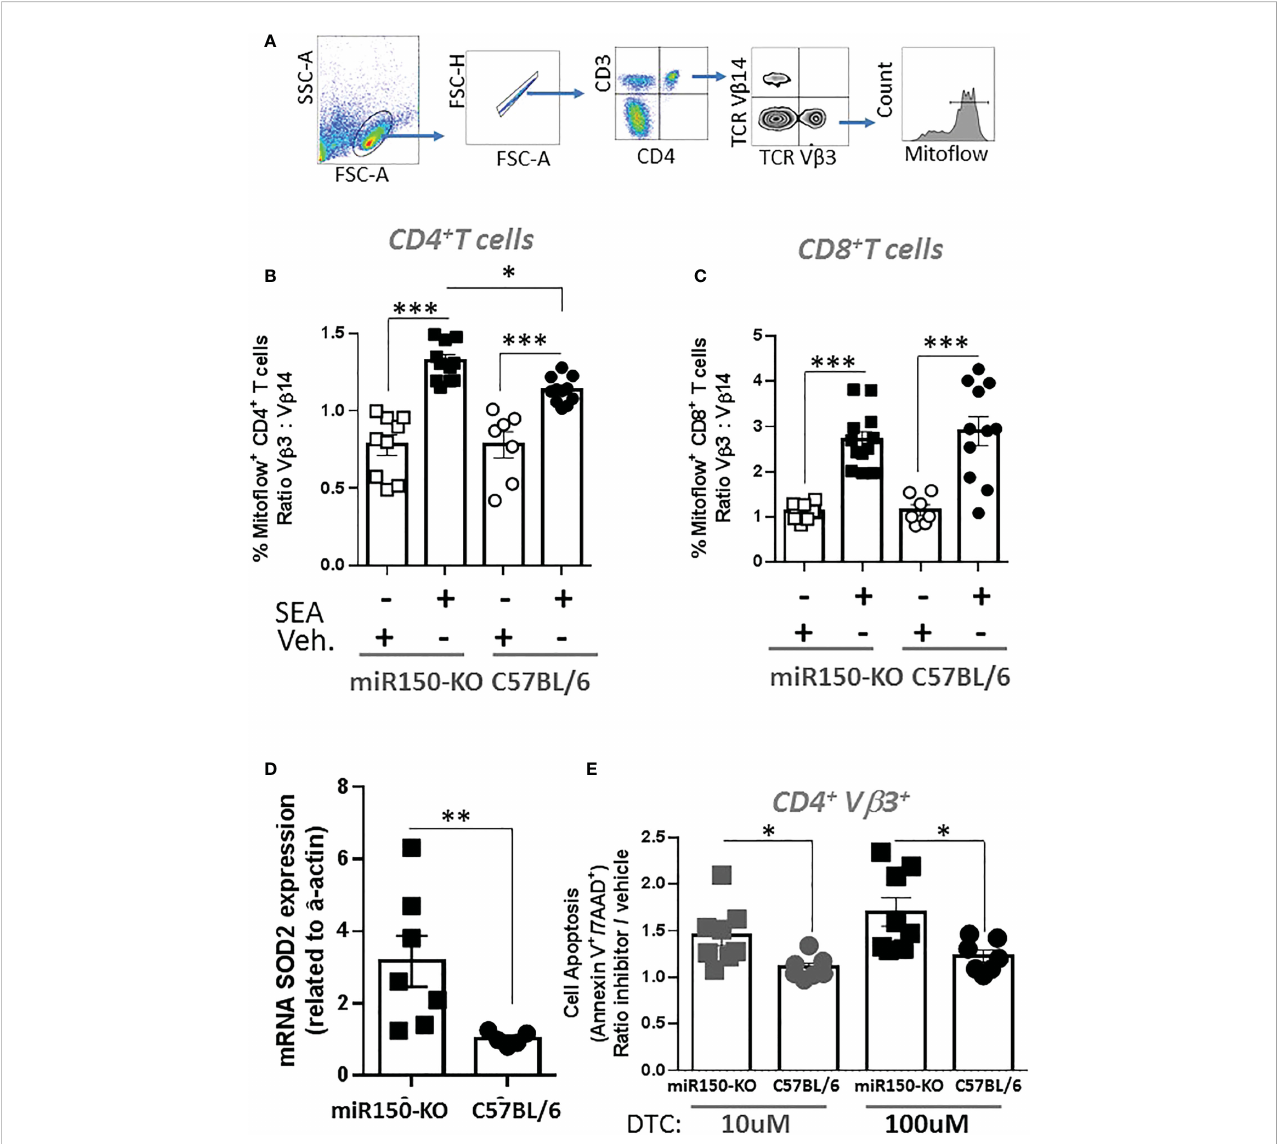
FIGURE 7 miR-150 controls superoxide-dependent apoptosis of antigen-speci fi c CD4 + T cells. (A) Splenocytes from miR-150-KO and WT mice analyzed 48 h post-SEA or -vehicle challenge and 4 h post-incubation ex vivo for expression of mito fl ow, an indicator of mitochondrial membrane potential. (B) Analysis of CD4 + T cells, and (C) CD8 + T cells mito fl ow staining is reported as a ratio of TCR: V b 3 vs. V b 14. Each dot represents a biological replicate from 3 independent experiments are shown +/- s.e.m. Statistical signi fi cance was evaluated by one way ANOVA. (D) mRNA SOD2 expression vs. actin from sorted antigen-speci fi c CD4 + T cells is reported. Each dot represents a biological replicate from 2 independent experiments are shown +/- s.e.m. Statistical signi fi cance was evaluated by student ’ s t-test. (E) Analysis of antigen-speci fi c CD4 + T cells incubated 4 h at 37°C in presence of the SOD2 inhibitor DTC. Apoptosis is reported as ratio inhibitor vs. vehicle as described and gated in Figure 5A. Each dot represents a biological replicate, three independent experiments are shown +/- s.e.m. Statistical signi fi cance was evaluated by one way ANOVA. (*p < 0.05, **p < 0.01, ***p <